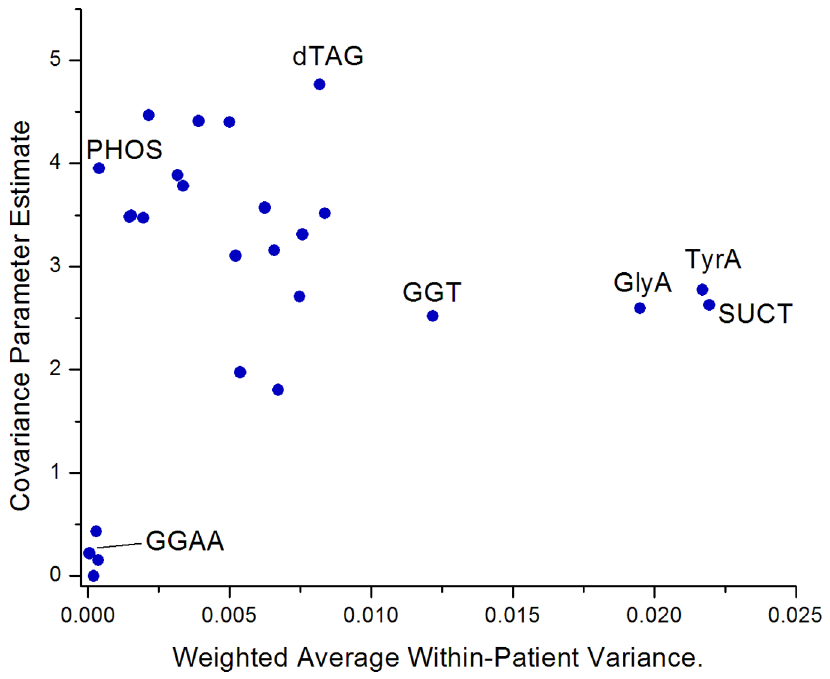
Figure 2. Covariance Parameter Estimate compared with observed weighted average within-patient variance.